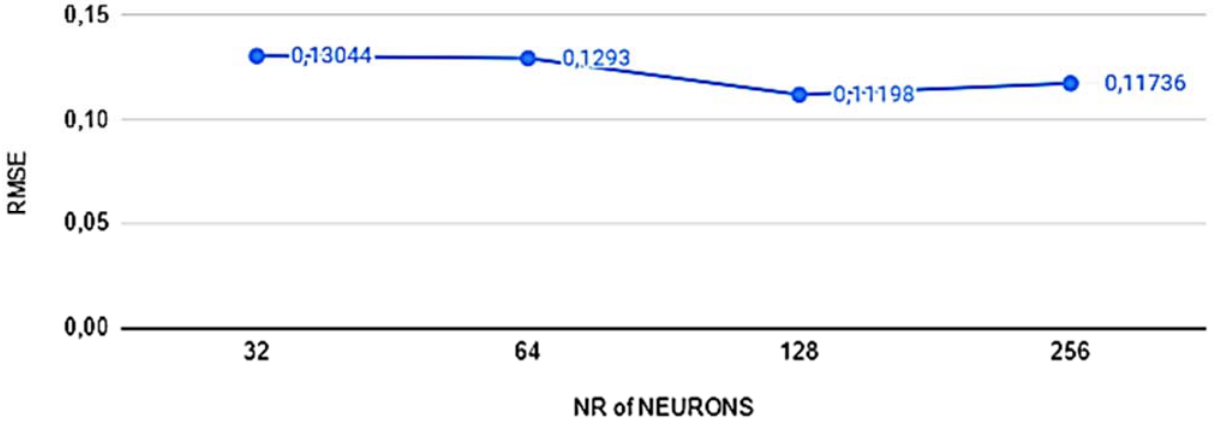
Figure 7. Average and maximum RMSE trend concerning the number of neurons in each layer–1 layer.